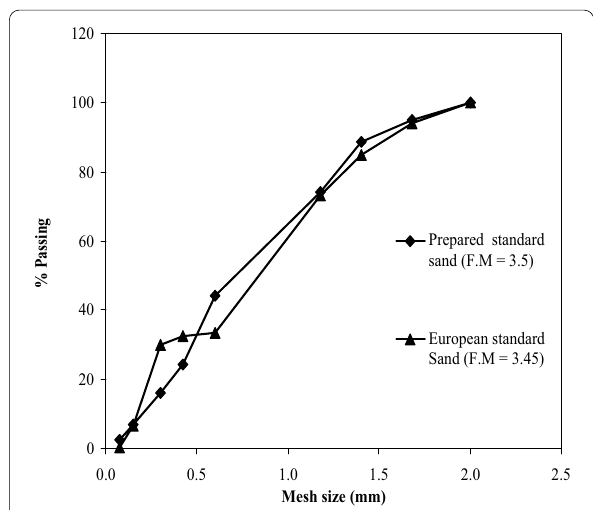
Fig. 1 Grading curves of SASS and ESSS (Ikotun and Ekolu 2010).